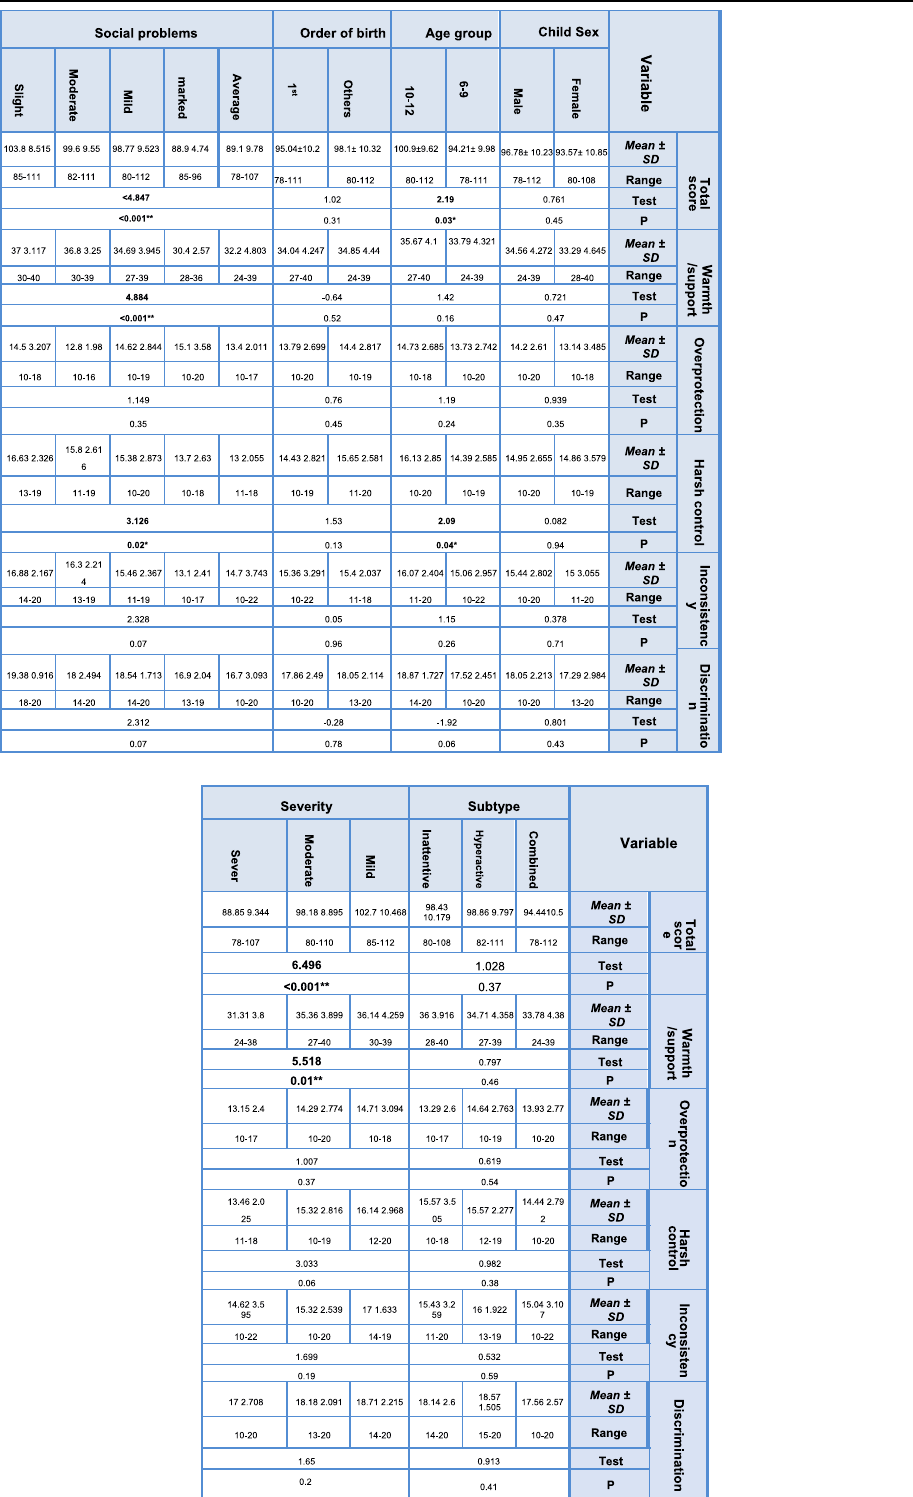
Table 2 Relationship between child characteristics and parenting attitudes of